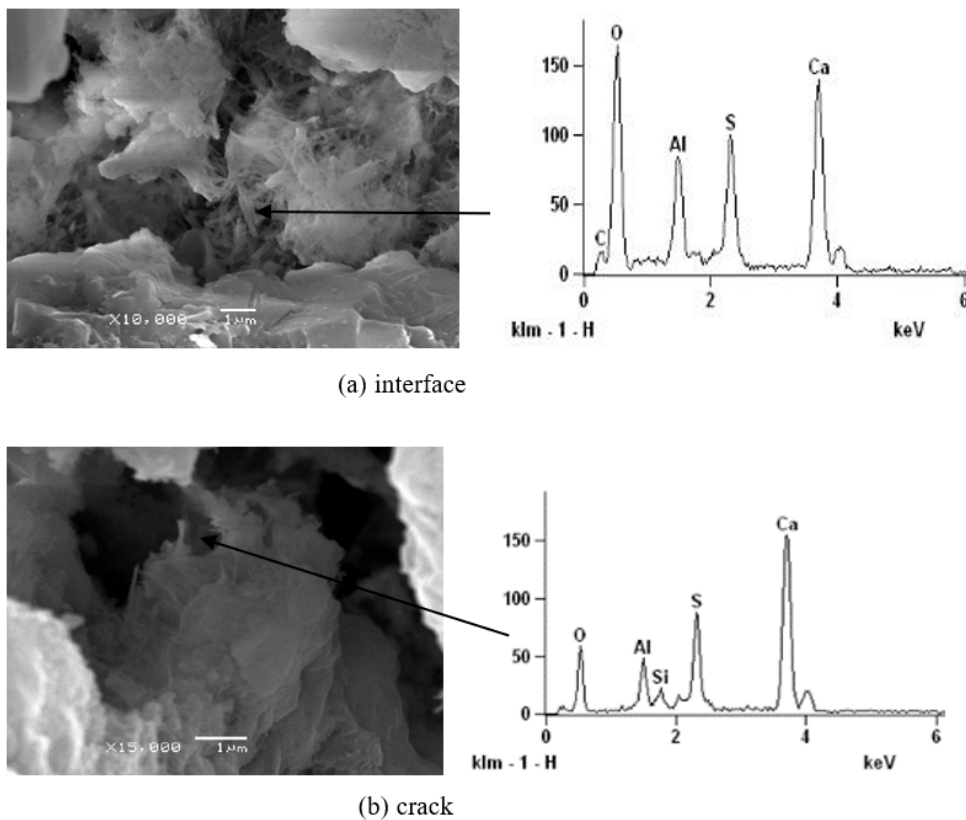
Figure 17. Microstructure of interface and crack in pastes embedded with gypsum particles greater than 2 mm at 90 d.